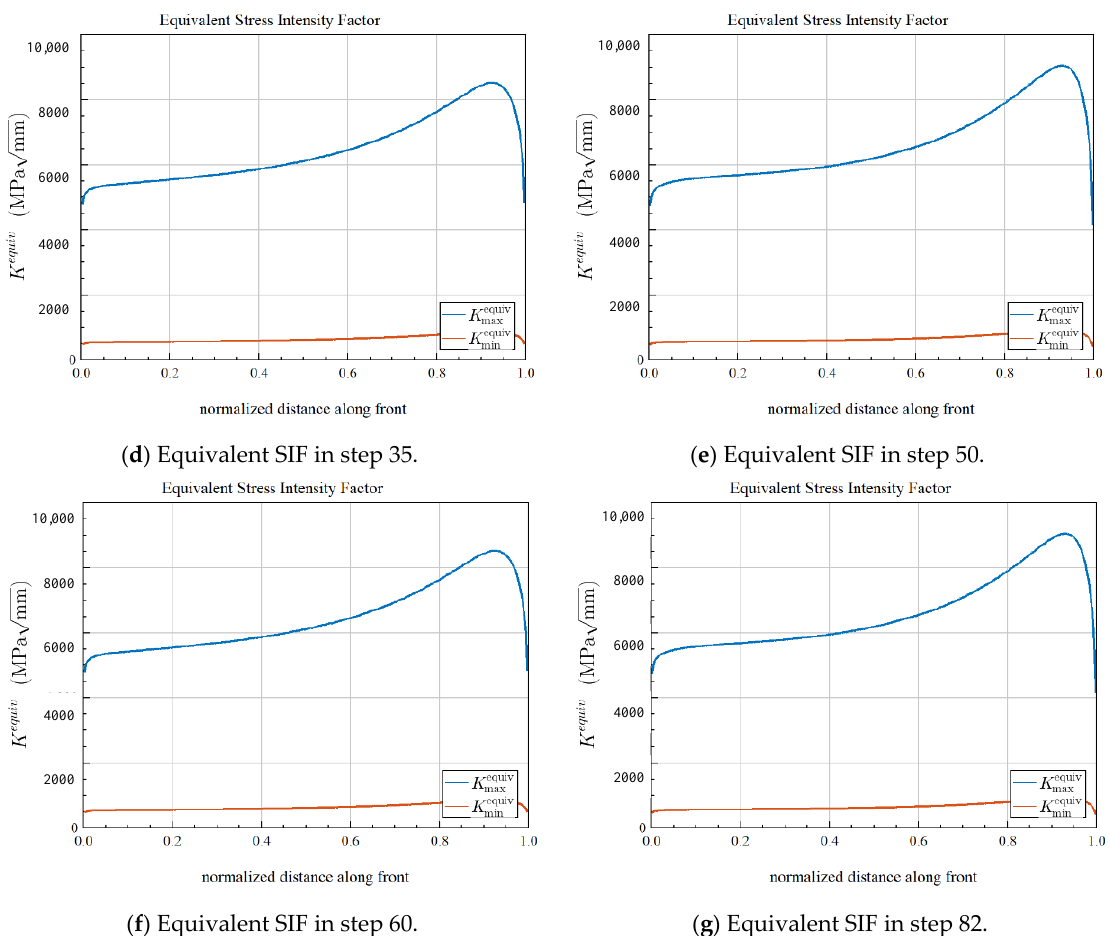
Figure 17. In each specified iteration, the equivalent intensity factors along crack front. ( a ) Cycle number vs. crack growth step; ( b ) K equiv along crack propagation front with iterative step = 5; ( c ) K equiv along crack propagation front with iterative step = 20; ( d ) K equiv along crack propagation front with iterative step = 35; ( e ) K equiv along crack propagation front with iterative step = 50; ( f ) K equiv along crack propagation front with iterative step = 60; ( g ) K equiv along crack propagation front with iterative step = 82.